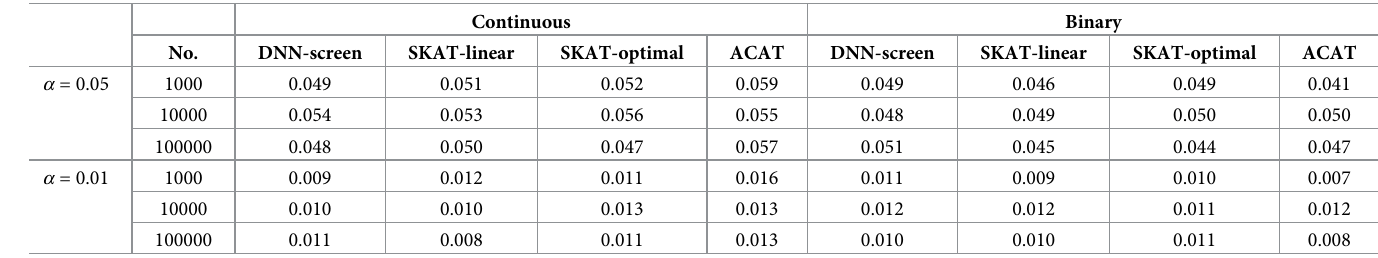
Table 1. The comparisons of type I errors based on 5000 Monte Carlo